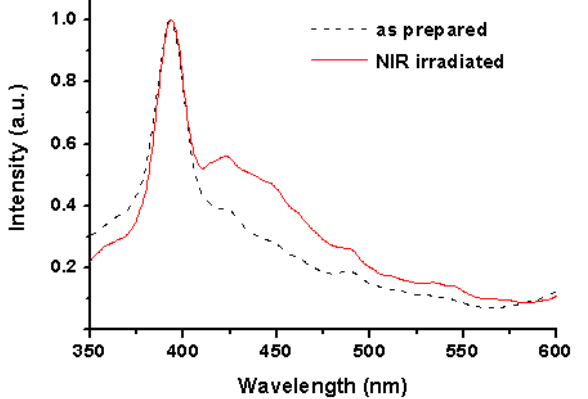
Figure 5. Emission spectra of pristine and IR irradiated preforms for an excitation wavelength of 230 nm. Both emission spectra are normalized to the peak at 392